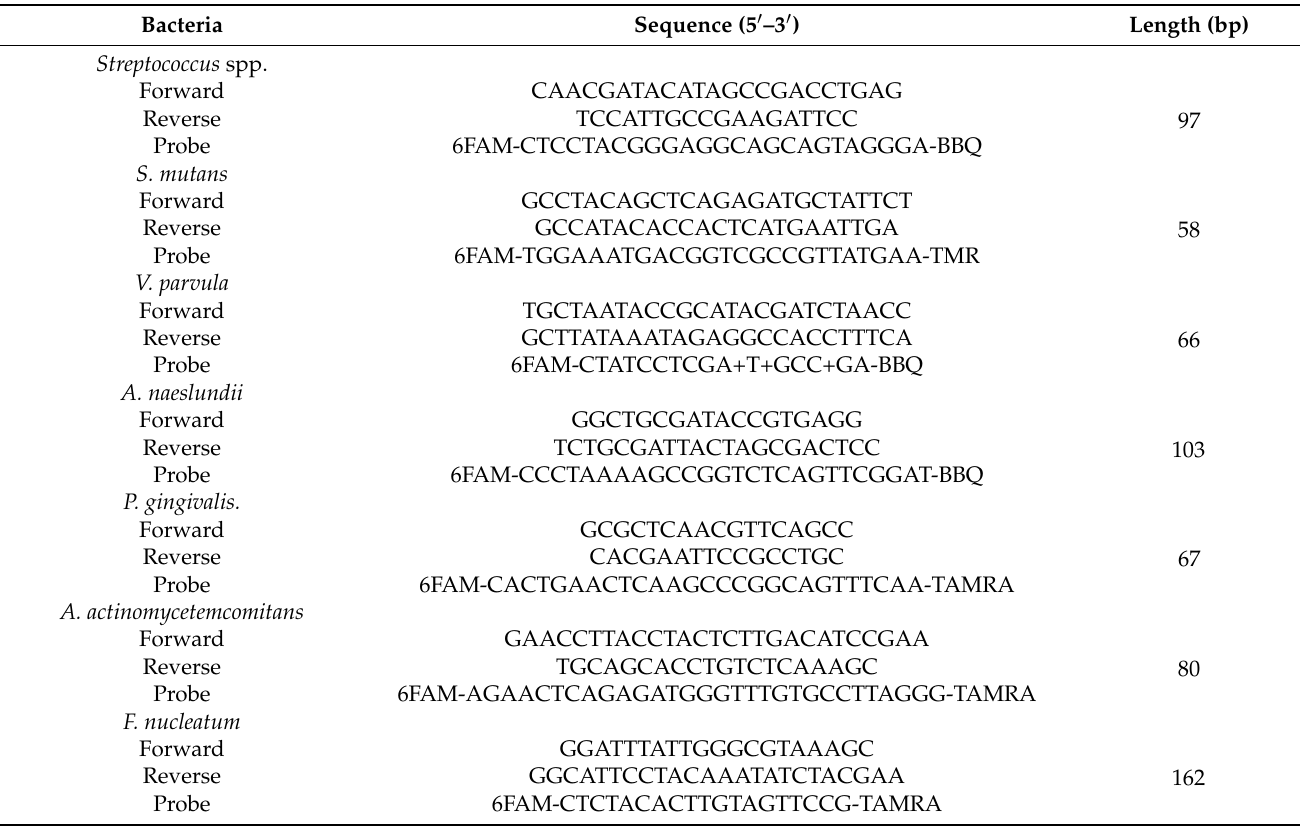
Table 1. Primers and probes used for quantification of genomic DNA from the target bacteria. Primers and probes were targeted against 16S rRNA gene (Obtained from Life Technologies Invitrogen (Carlsbad, CA, USA) and Roche (Roche Diagnostic GmbH; Mannheim,